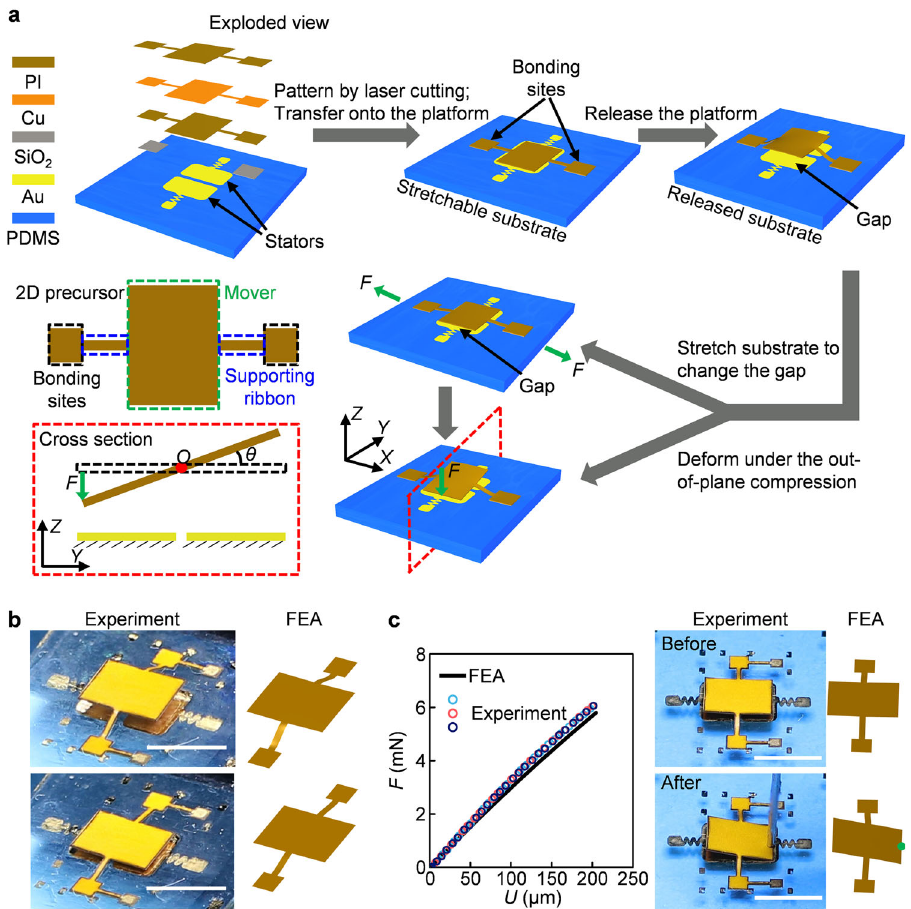
Fig. 1 Design, fabrication, measurements, and simulations of the 3D capacitive sensor through mechanics-guided assembly. a Schematic illustration of fabrication procedures for the 3D capacitive sensor. b Optical images and corresponding FEA predictions of 3D seesaw-like mesostructures in polyimide (25 μ m)/Cu (25 μ m)/polyimide (25 μ m) under different applied strains ( ε appl = 0% and 3%). c Measured and simulated force responses of the 3D seesaw-like mesostructure. The right panel shows the optical images and FEA predictions of 3D mesostructures before and after out-of-plane compression. Scale bars, 4